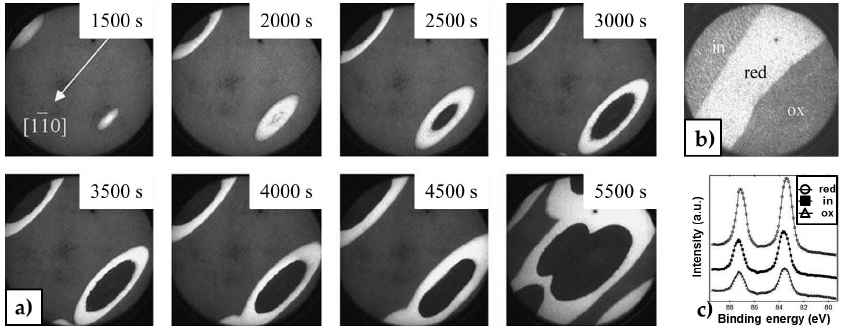
Figure 9. LEEM and micro-XPS study of front propagation and mass transport: ( a ) LEEM images under O 2 + H 2 reaction illustrating the ignition and propagation of reduction/oxidation fronts. Field of view = 20 μ m. Conditions of acquisition: T = 550 K, P O ( b ) Au 4f 7/2 map acquired during front propagation illustrating the lateral inhomogeneity induced by the reduction/oxidation front; ( c ) Au 4f spectra measured in the different regions presented in ( b ). Reprinted from [153]. Copyright 2004, Elsevier.